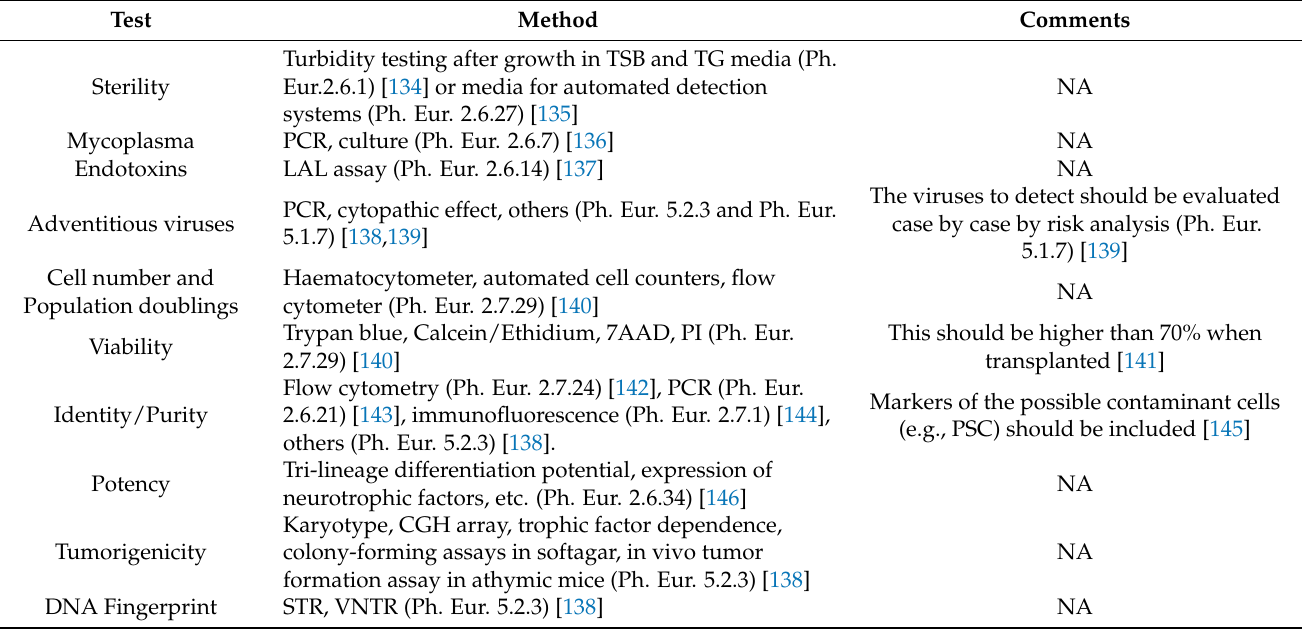
Table 3. Common quality control tests performed to release NSC-based